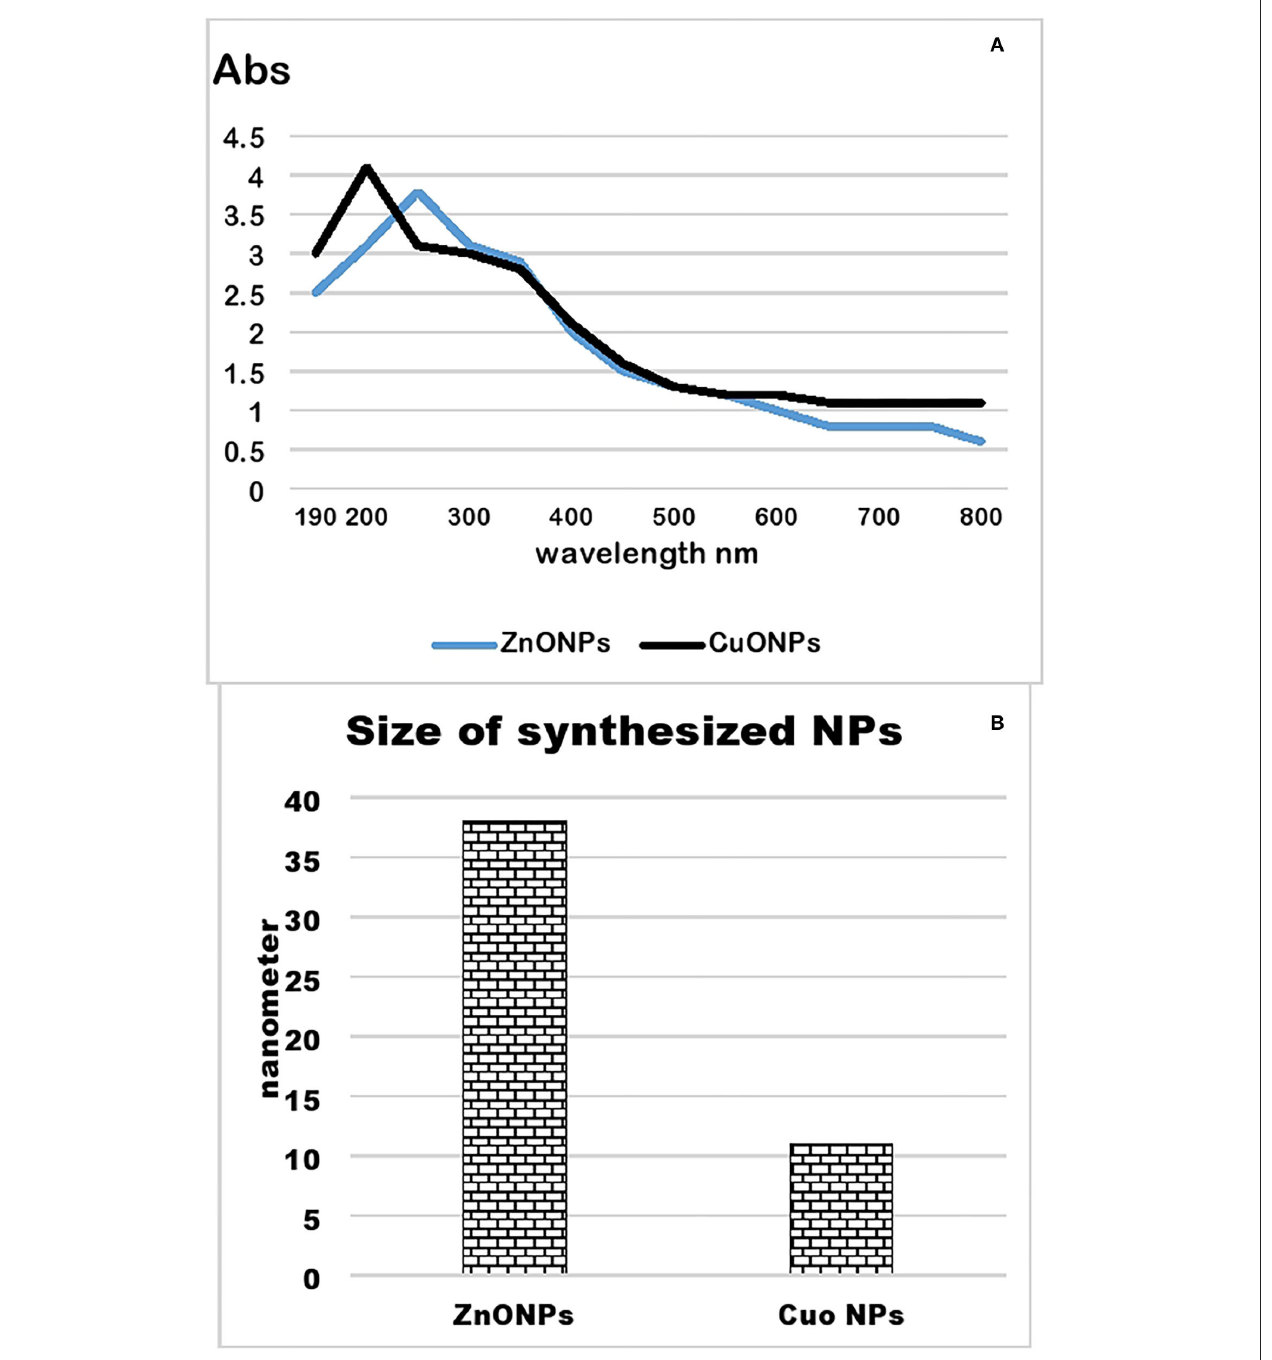
FIGURE 6 | UV-visible spectrum (A) and particle size analysis (B) of zinc and copper oxide nanoparticles.